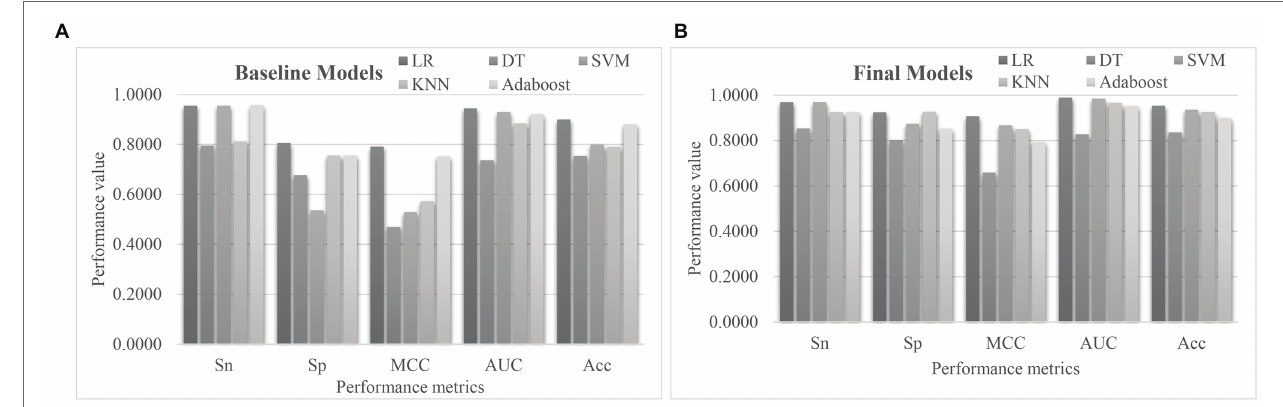
FIGURE 7 | Performance comparison of the five classification algorithms. The S5FCV strategy was used to train the five classification algorithms using (A) all the transcriptomic features, and (B) the 50 EnRank-detected biomarkers. The horizontal axis gave the performance metrics sensitivity (Sn), specificity (Sp), Matthews’ Correlation Coefficient (MCC), AUC, and accuracy (Acc). The vertical axis gave the values of these performance metrics.